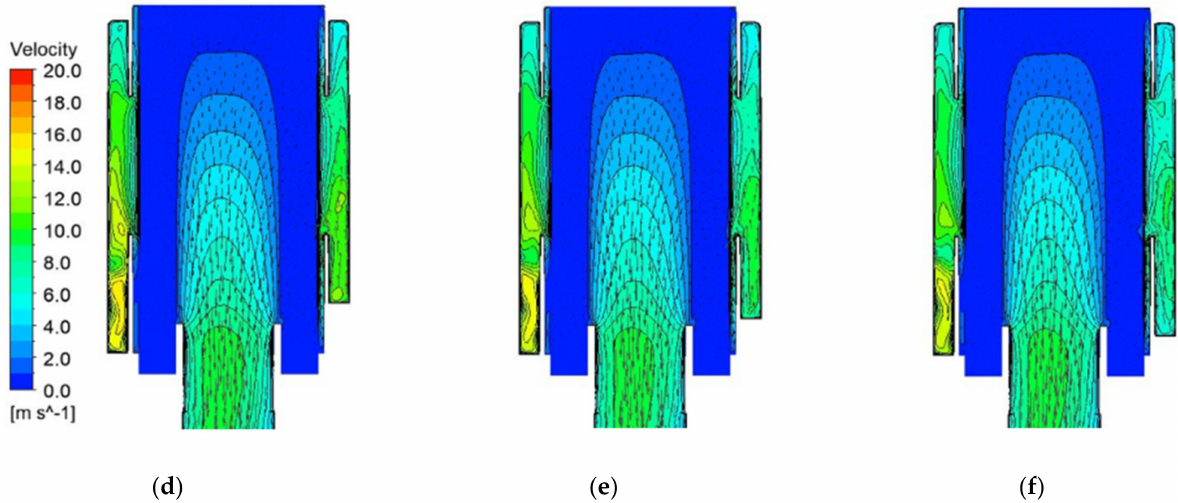
Figure 13. Pressure and velocity contour on plan specified Figure 12 according to change in design variable α at 4500 rpm condition: pressure contours at ( a ) α = 30 ◦ , ( b ) α = 40 ◦ and ( c ) α = 50 ◦ , and velocity contours at ( d ) α = 30 ◦ , ( e ) α = 40 ◦ and ( f ) α = 50 ◦ .